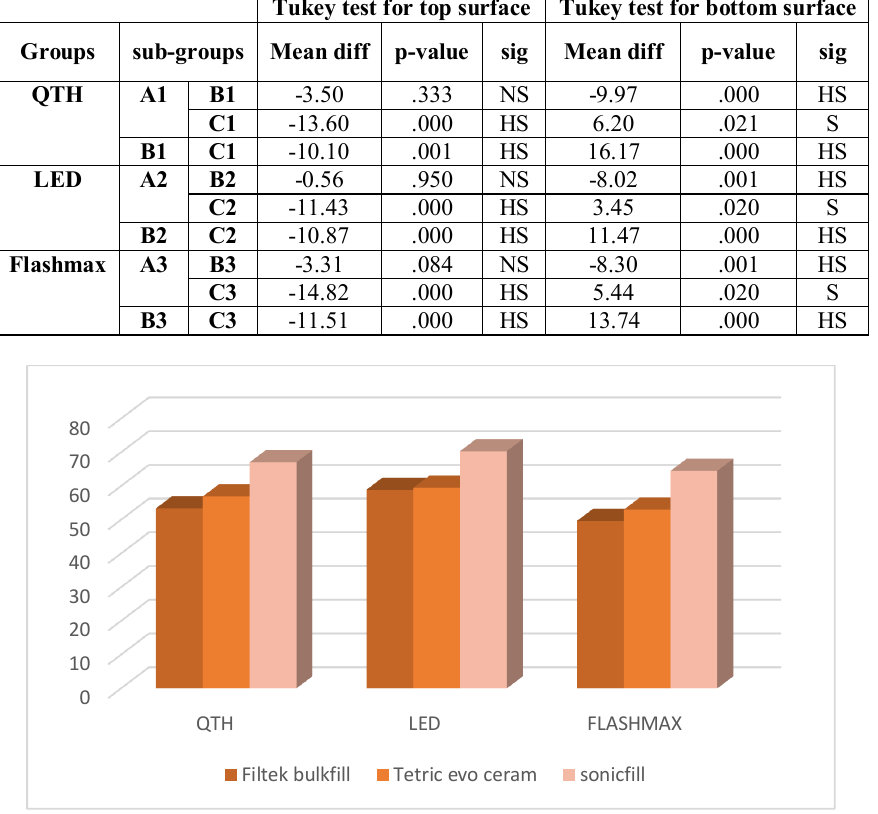
Figure 1: A chart show the effect of curing system on VHN for the top surfaces of the